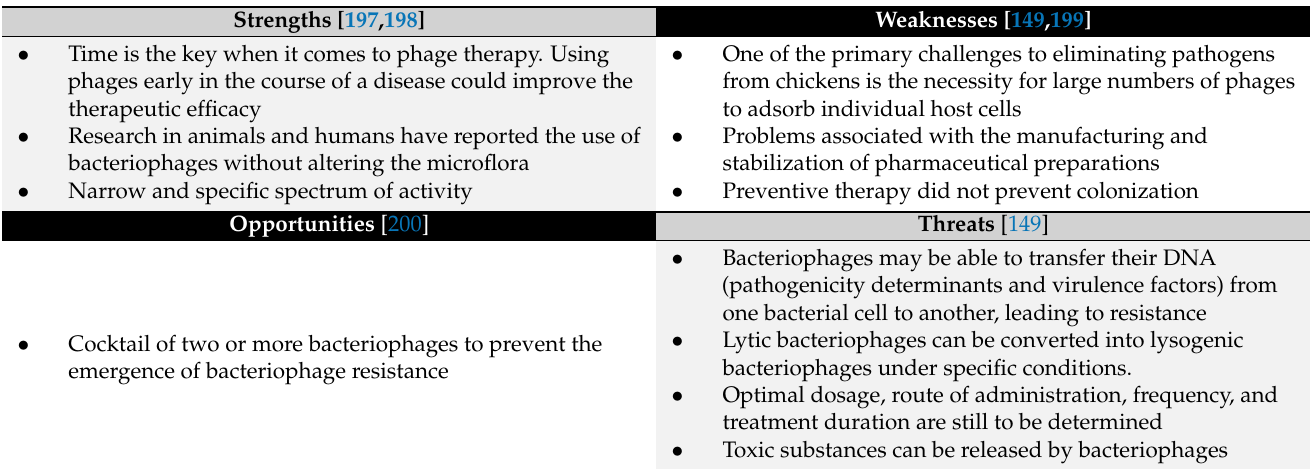
Table 7. SWOT analysis of